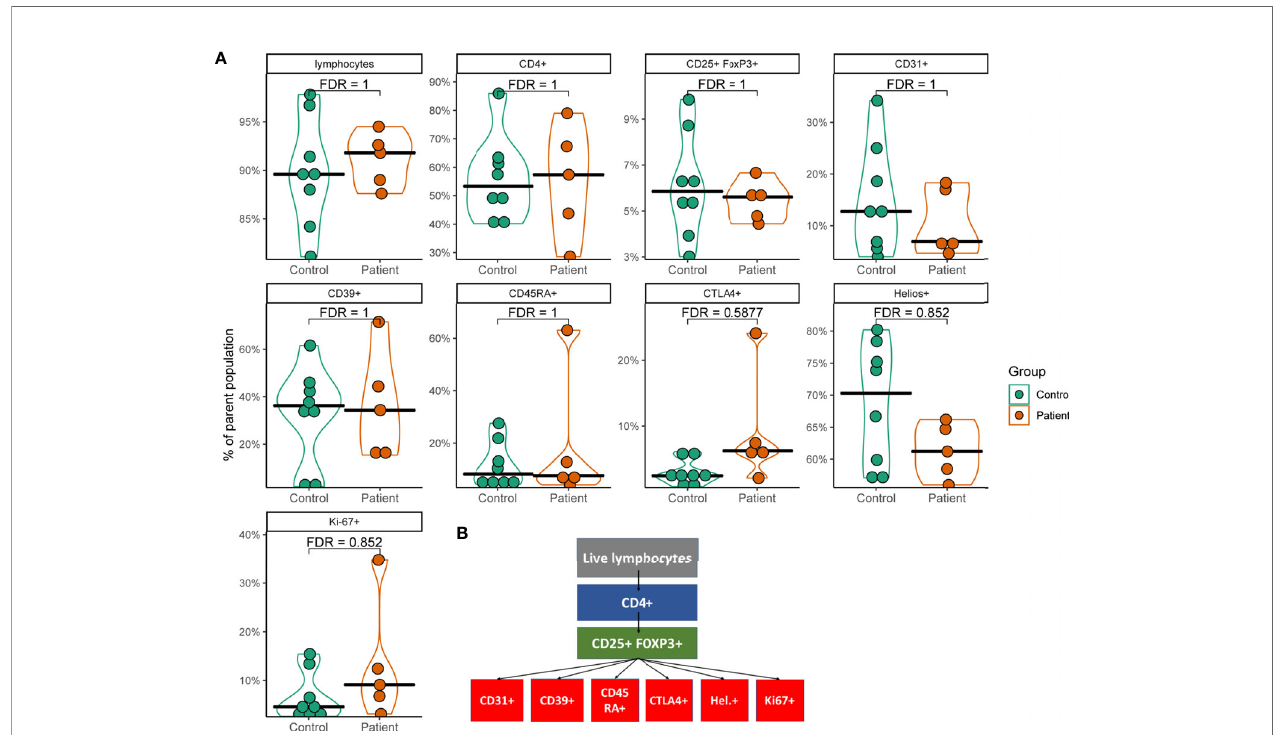
FIGURE 1 | Violin plots of fl ow cytometry data from a subset of APS-1 patients and healthy subjects. (A) Plots show different cell populations positive for markers and their percentages relative to the gated parent population. Statistical analysis was performed by using Mann-Whitney U test with Benjamini-Hochberg correction (FDR) in R. Gating strategy is displayed in (B)